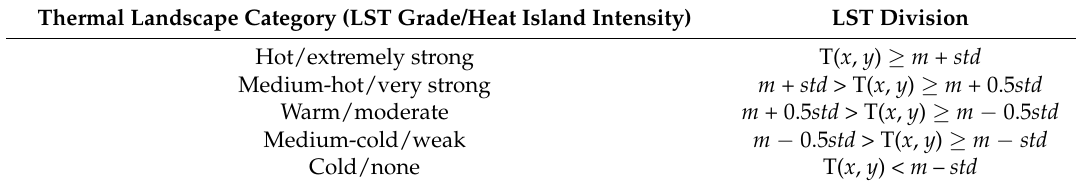
Table 3. Thermal landscape classification obtained using the mean-standard deviation